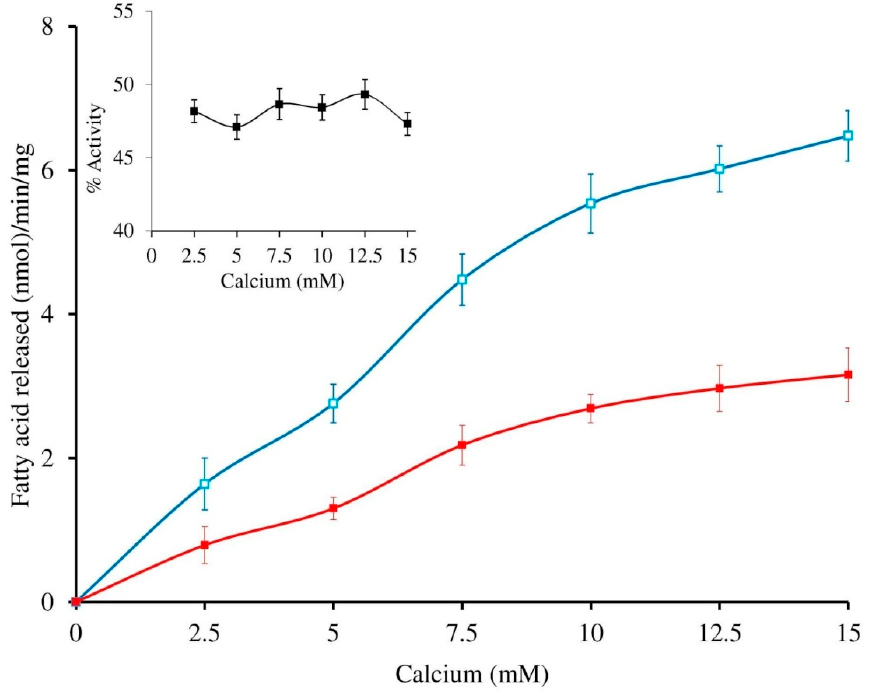
Figure 4. Effect of calcium concentration on sPLA2-IIA inhibition: The sPLA2 IIA activity was measured with calcium concentration ranges from 2.5 to 15 mM with ( ■ ) and without ( □ ) IC 50 concentration of sinapic acid. The sPLA 2 -IIA inhibition is shown in the inlet. The data are expressed as mean ± standard deviation (n = 3).